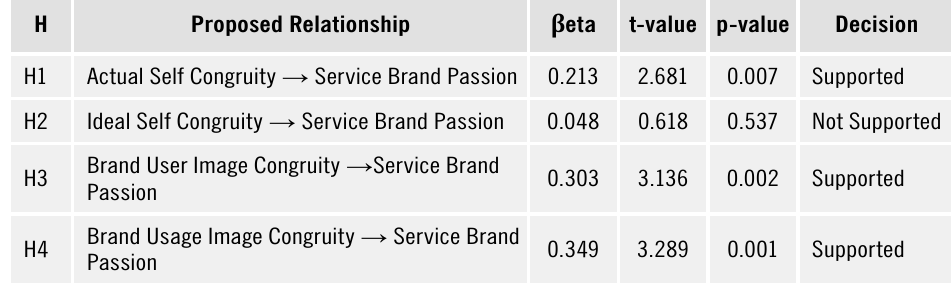
Table 2. Structural equation modeling